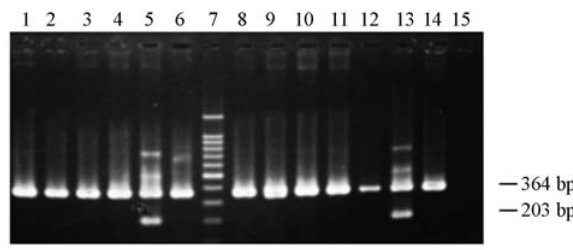
Figure1 -Allele-specificPCRanalysisofthe JAK2 geneinhematological neoplasms.Tenof20 μ LofPCRproductswereseparatedbyelectrophore- sis on 2% agarose gel, stained with ethidium bromide and visualized by ul- traviolet illumination. The size of the products is indicated on the right. Aberrant bands were detected in one of the AML samples (lane 5). Lane 1, AML01; lane 2, MDS01; lane 3, ALL01; lane 4, BAL01; lane 5, AML02; lane 6, AML03; lane 7, 100 bp ladder; Lane 8, ALL02; lane 9, AML04; lane 10, AML05; lane 11, AML06; lane 12, CLL01, lane 13, PV01; lane 14, CML01, lane 15, water. Aberrant bands of PV01 are shown as positive control (lane 13).